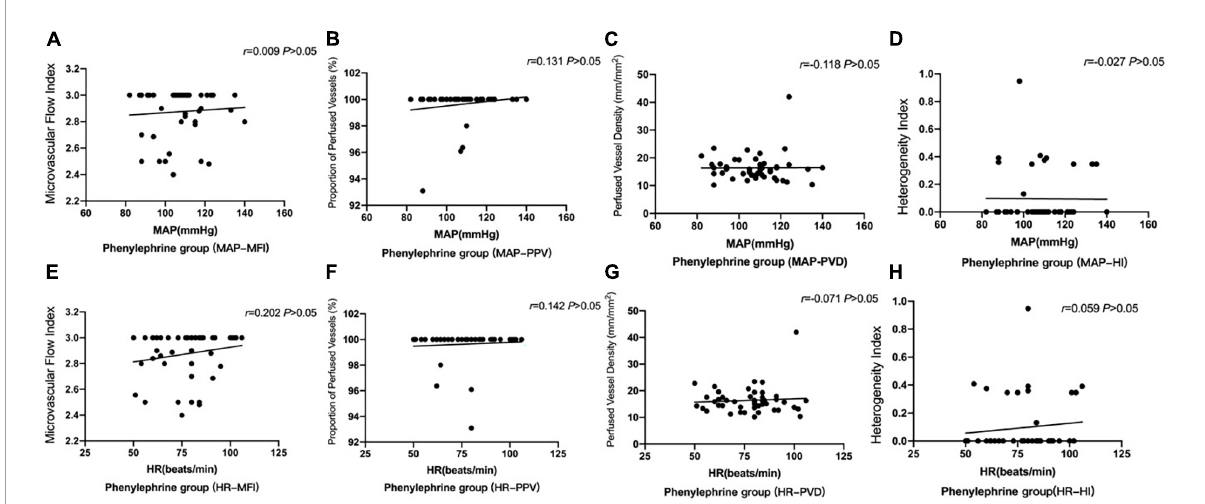
FIGURE5 Correlation of MAP with microcirculation parameters in the ephedrine group (A–D) . Correlation of HR with microcirculation parameters in the ephedrine group (E–H) . (A) The correlation of MAP with MFI in the ephedrine group ( P > 0.05). (B) The correlation of MAP with PPV in the ephedrine group ( P > 0.05). (C) The correlation of MAP with PVD was negative in the ephedrine group ( P < 0.05). (D) The correlation of MAP with HI in the ephedrine group ( P > 0.05). (E) The correlation of HR with MFI in the ephedrine group (P > 0.05). (F) The correlation of HR with MFI in the ephedrine group ( P > 0.05). (G) The correlation of HR with MFI in the ephedrine group ( P > 0.05). (H) The correlation of HR with MFI in the ephedrine group ( P >